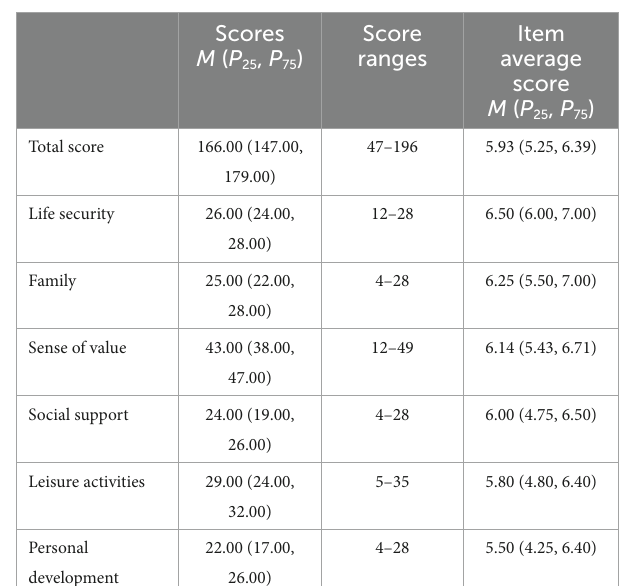
TABLE 1 Score of the Sources of Meaning in Life Scale for the Elderly ( N =